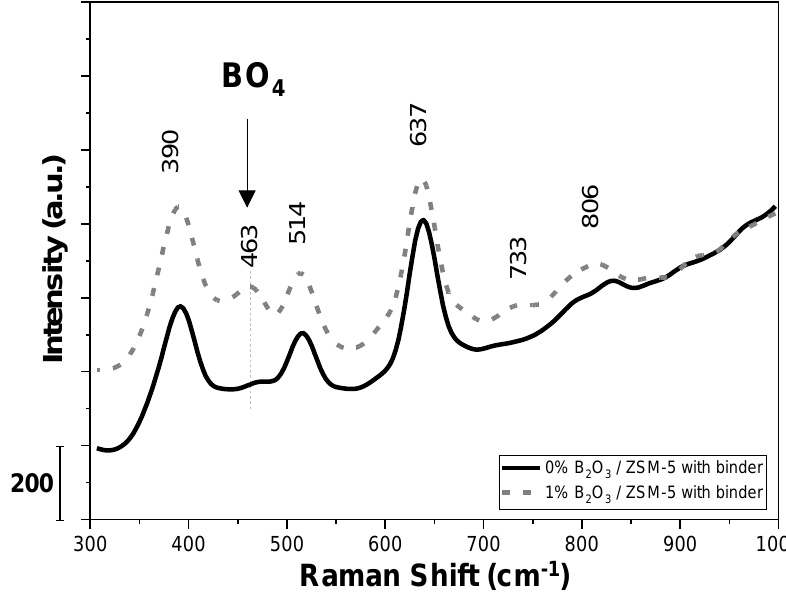
Figure 7. Raman spectra collected using a 488-nm laser for Samples #12 and #13. This is a higher-resolution view of the top two traces of spectra in Figure 6.